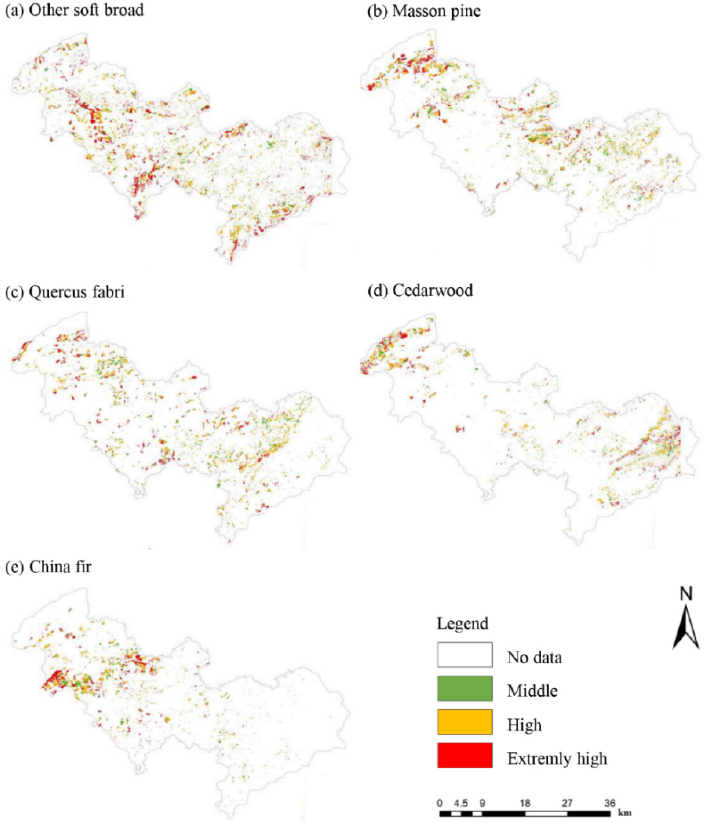
Figure 10. Spatial distribution map of landslide susceptibility of dominant tree species in Jinsha County.